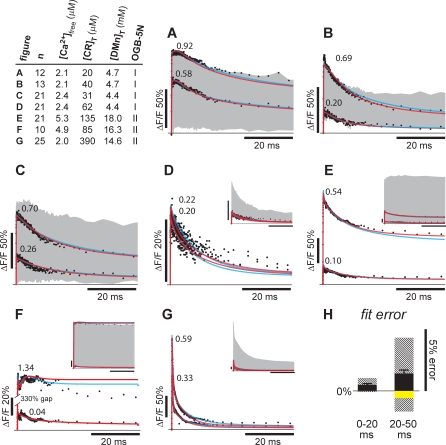
Fitting of the Ca2+ Uncaging Data with the Model of Two Pairs of Cooperative Sites and One Individual SiteA typical dataset (•) consisting of 14 randomly chosen traces is shown in (A–G). The traces were selected from seven different experimental conditions, two per condition. The table shows the values for the four variables differing in conditions (A–G). Individual data points (•) are fitted with either the new model (red lines) or the MWC model (blue lines), taking into consideration the four variables listed in the table, whereas the values for k
on's, k
off's, K
d(app), L
0, k
+(L0), and the n
H for CR are identical for all fits within a set. The amount of uncaging is fitted independently for every trace. For the selected examples, it is expressed as percentage of total [DMn]. The gray areas indicate the whole range of uncaging experiments for each experimental condition; the smaller insets in (D–G) show the whole range of traces, whereas the y-axis ranges in the main panels (D–G) were selected to optimally show the 14 selected traces. More individual curves can be seen in Figure S1. Black scale bars in (A–G) insets indicate 50% ΔF/F (y-axis) or 20 ms (x-axis). (H) To assess the goodness of fit by the new model, the averaged relative deviations of the fit from the data are shown as black bars ± the standard error of the mean for the first 20 ms of the fit (left) and for 20–50 ms of the fit (right bar). The largest single deviations in either direction found in all of the sets are indicated by striped bars. The yellow bars indicate the deviation observed in the selected set of traces displayed in (A–G). The scale bar indicates 5% error/deviation from data. In the table for the OGB-5N column, I refers to lot number 34B1–2 and II to lot 15C1–2.